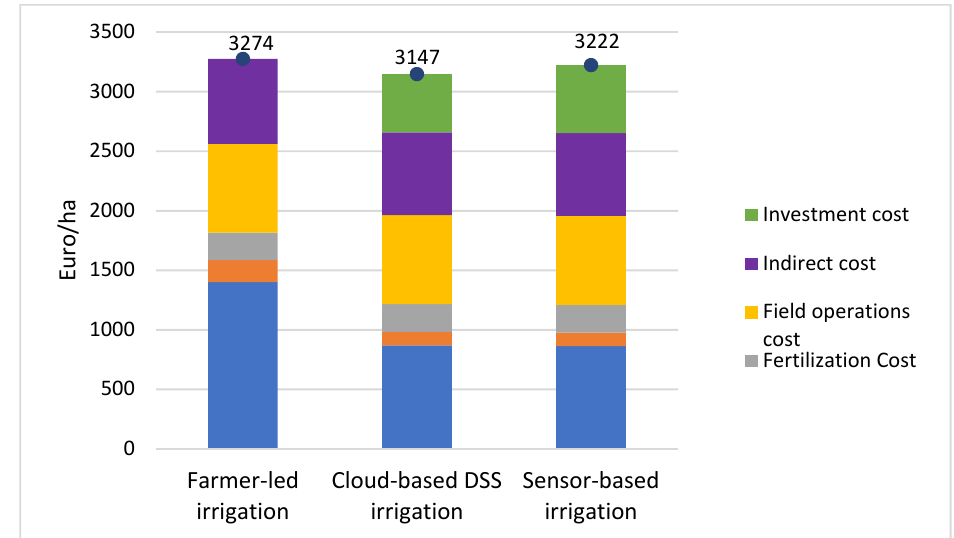
Figure 6. Life cycle cost of zucchini cultivation under different irrigation management strategies.